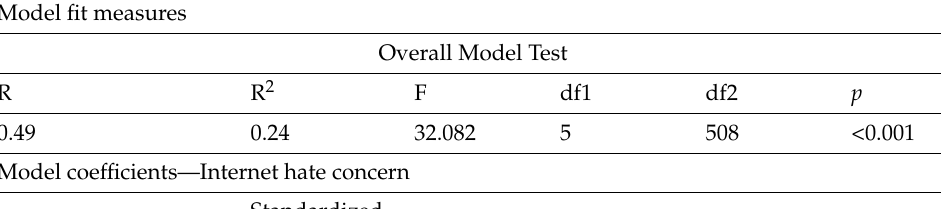
Table 3. Regression model predicting higher Internet Hate Concern in ordinary Internet Users ( n = 514). Model fit